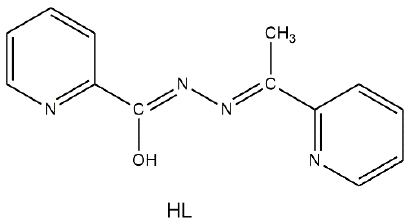
Figure1. Structuralformulaofthefreeligand N ’-(1-(pyridin-2-yl)ethylidene)pyridine-2-carbohydrazide, Figure 1. Structural formula of the free ligand drawn in its enol-imino tautomer, and its N ’-(1-(pyridin-2-yl)ethylidene)pyridine-2-carbohydrazide, drawn in its enol-imino tautomer, and its abbreviation.